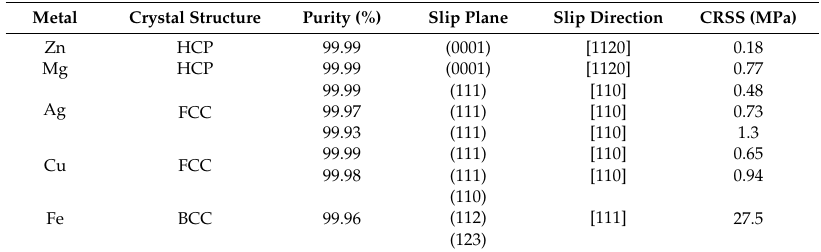
Table 1. Critical resolved shear stresses of some metal single crystals with di ff erent crystal structures at room